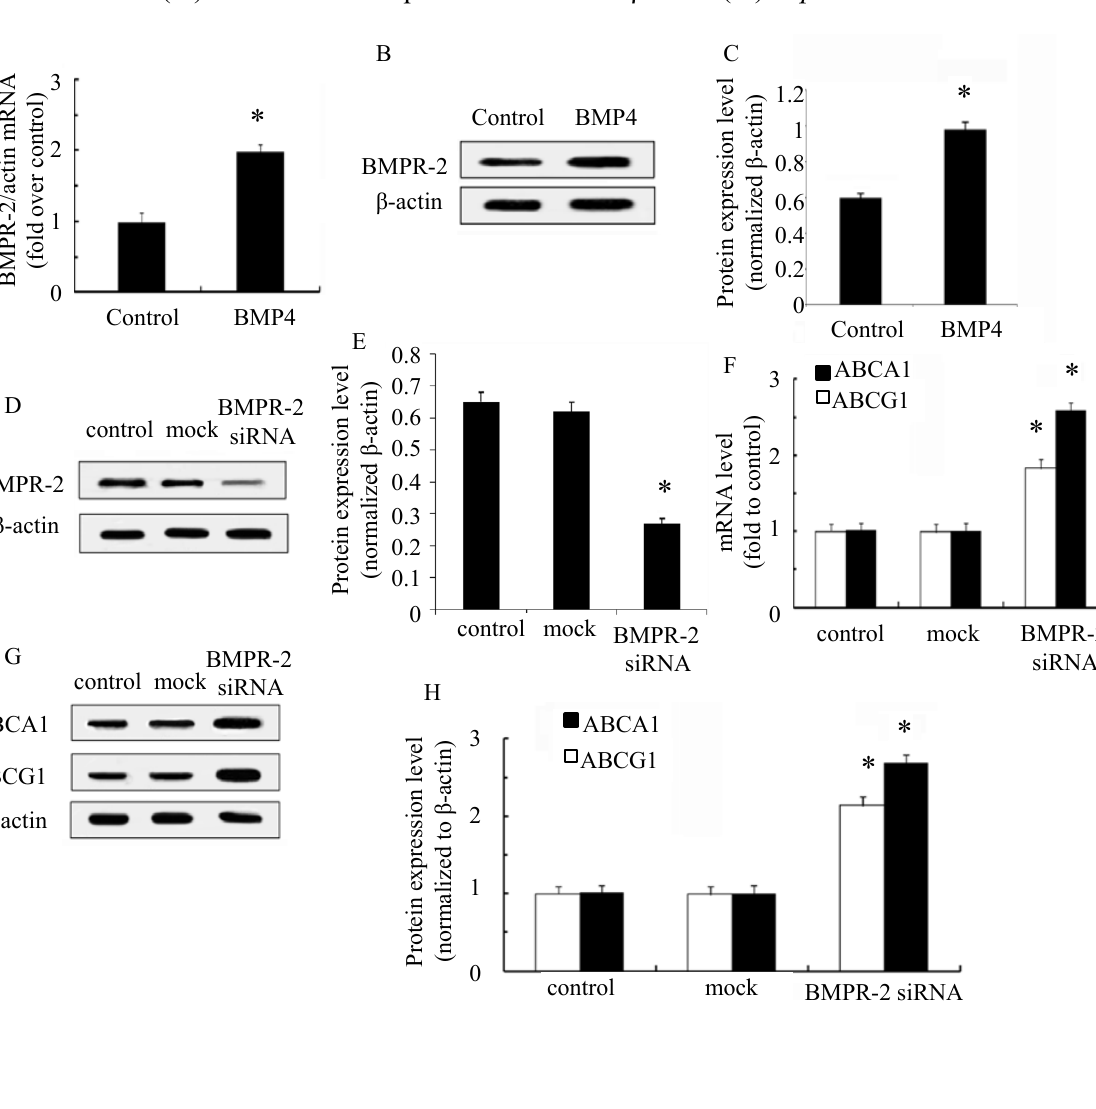
Figure 4. BMPR-2 is responsible for BMP4 inhibition of ABCA1 and ABCG1 expression. Unless otherwise specified, all macrophages below were cultured in DMEM with oxLDL. After treatment with PBS (control) or BMP4, macrophages were cultured for 48 h. Then the BMPR-2 expression was detected using RT-PCR ( A ), Western blots ( B ) and its quantification with relative densitometry of BMPR2/β-actin ( C ). After treatment with PBS (control), mock, or BMPR-2 siRNA, the expression of BMPR-2 in macrophages were evaluated using Western blots ( D ) and its quantification with relative densitometry of BMPR2/β-actin ( E ), then the ABCA1 and ABCG1 expression were using RT-PCR ( F ), Western blots ( G ) and its relative quantification over β-actin ( H ). * p <